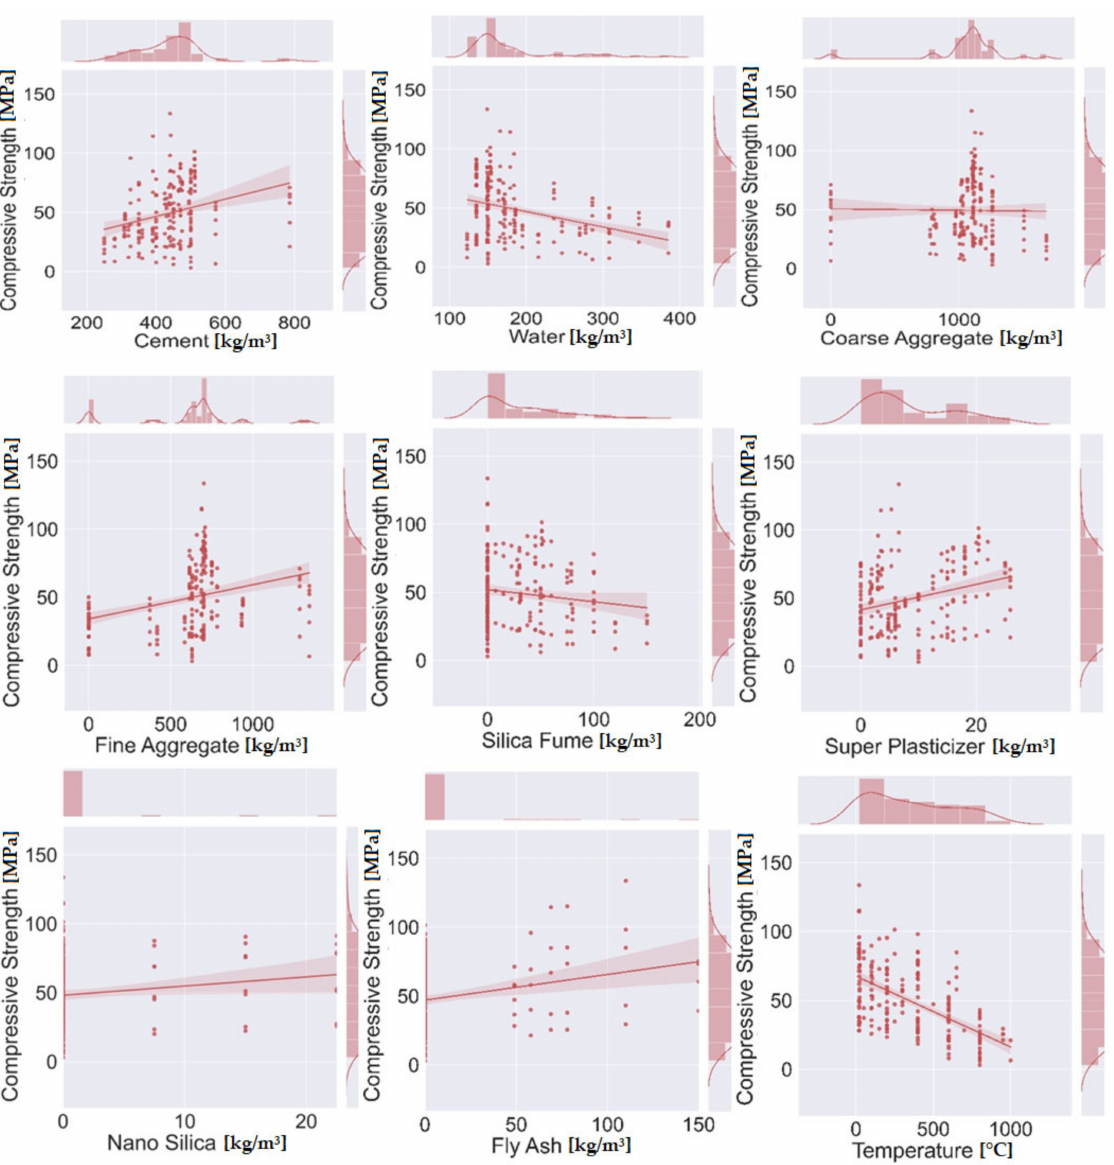
Figure 1. Contour plots showing the relative distribution of the